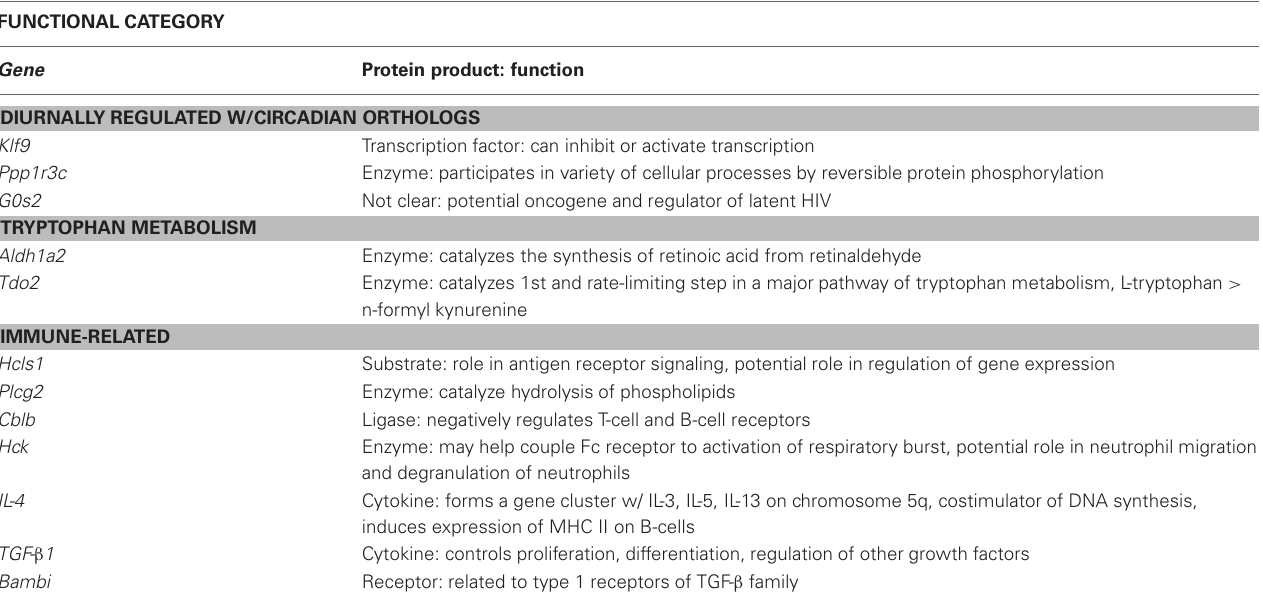
Table 7 | Functional role of proteins encoded by genes of